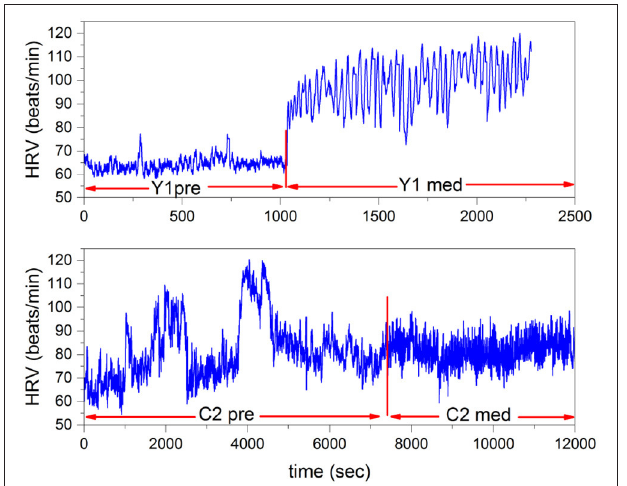
FIGURE 5 | The power spectra S ( ω ) of Chi meditators (C1, C2) before, on the right, and during meditation, on the left. In the left panels, the spectra for C1 and C2 meditators consist of significant bumps at ω = 0.34( rad / sec ) and ω = 0.38( rad / sec ) respectively, each induced by meditation.